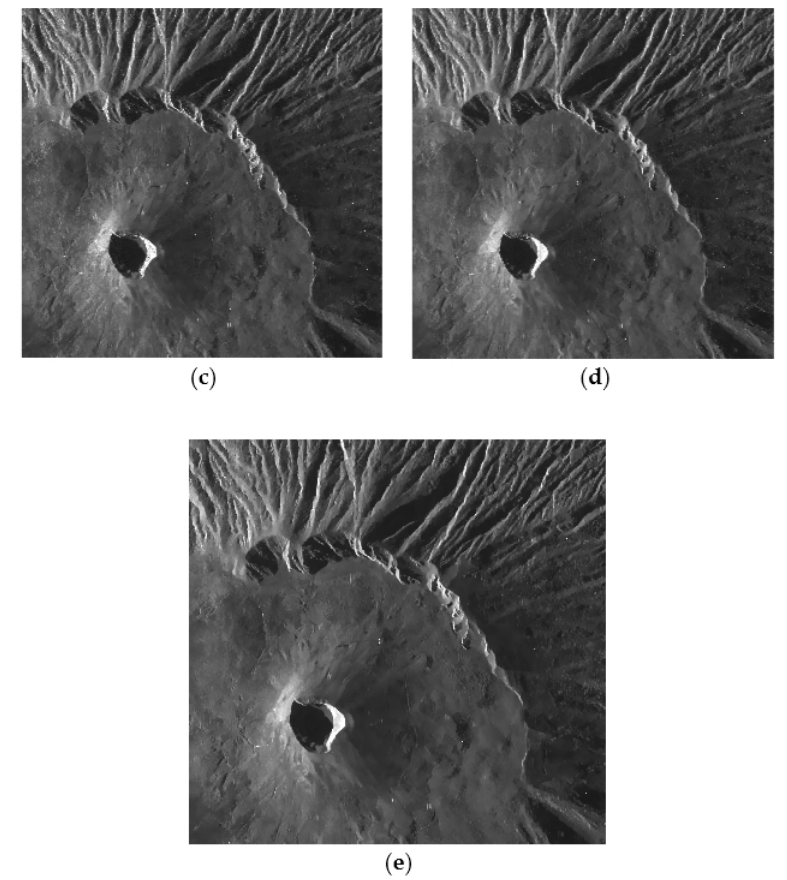
Figure 13. ( a ) 1940 ˆ 2000 single-look stripmap COSMO-SkyMed SAR image of the Vesuvius-Mt. Somma close to Naples, Italy. Pixel spacing is 2.07 m and 1.18 m in azimuth and slant range, respectively. The red box indicates the region used for the coefficient of variation evaluation. ( b ) 42-look SAR image obtained via temporal multilook and used as the reference. SB-SARBM3D by exploiting a 5-m ( c ), 90-m ( d ), and 1-km ( e )